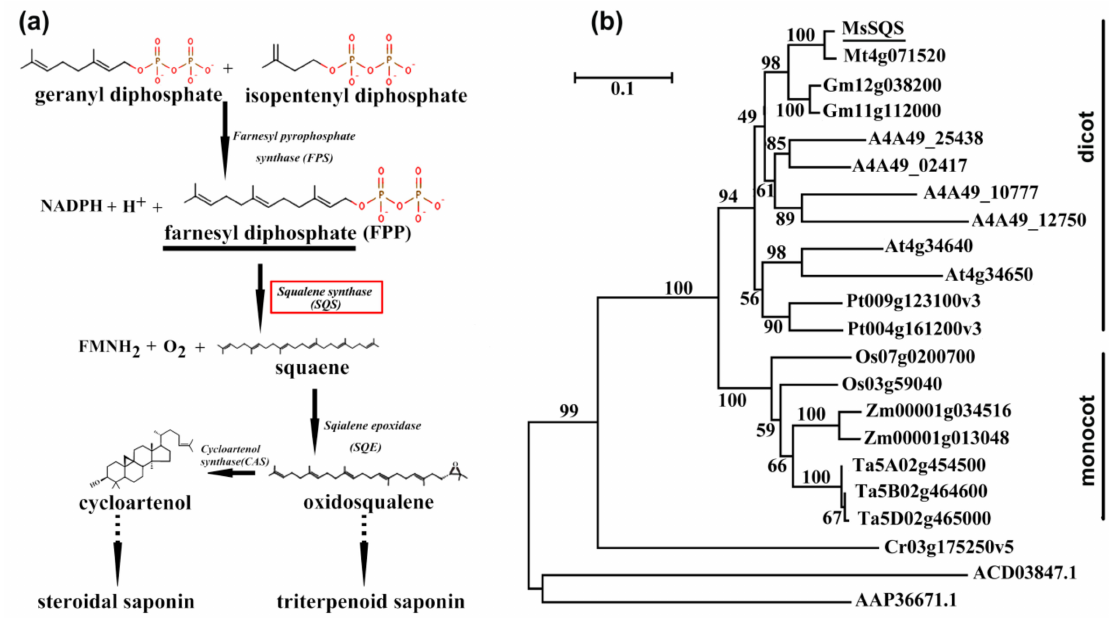
Figure 1. Illustration of the synthesis pathway of triterpene saponins and phylogenetic analysis of SQS proteins from the indicated species. ( a ) Illustration of the major saponins biosynthesis pathway in plants. Squalene synthase ( SQS ) is boxed in red. ( b ) The predicted polypeptide of SQS from the indicated species was analyzed using MEGA (version 6) [32]. The bar represents the evolutionary distance and MsSQS was underlined. Gene accession numbers based on EnsemblPlants (http: // plants.ensembl.org / index.html) are as follows: Arabidopsis thaliana (At): At4g34640, At4g34650; Chlamydomonas reinhardtii (Cr): Cr03g175250v5; Glycine max (Gm): Gm12g038200, Gm11g112000; Homo sapiens :